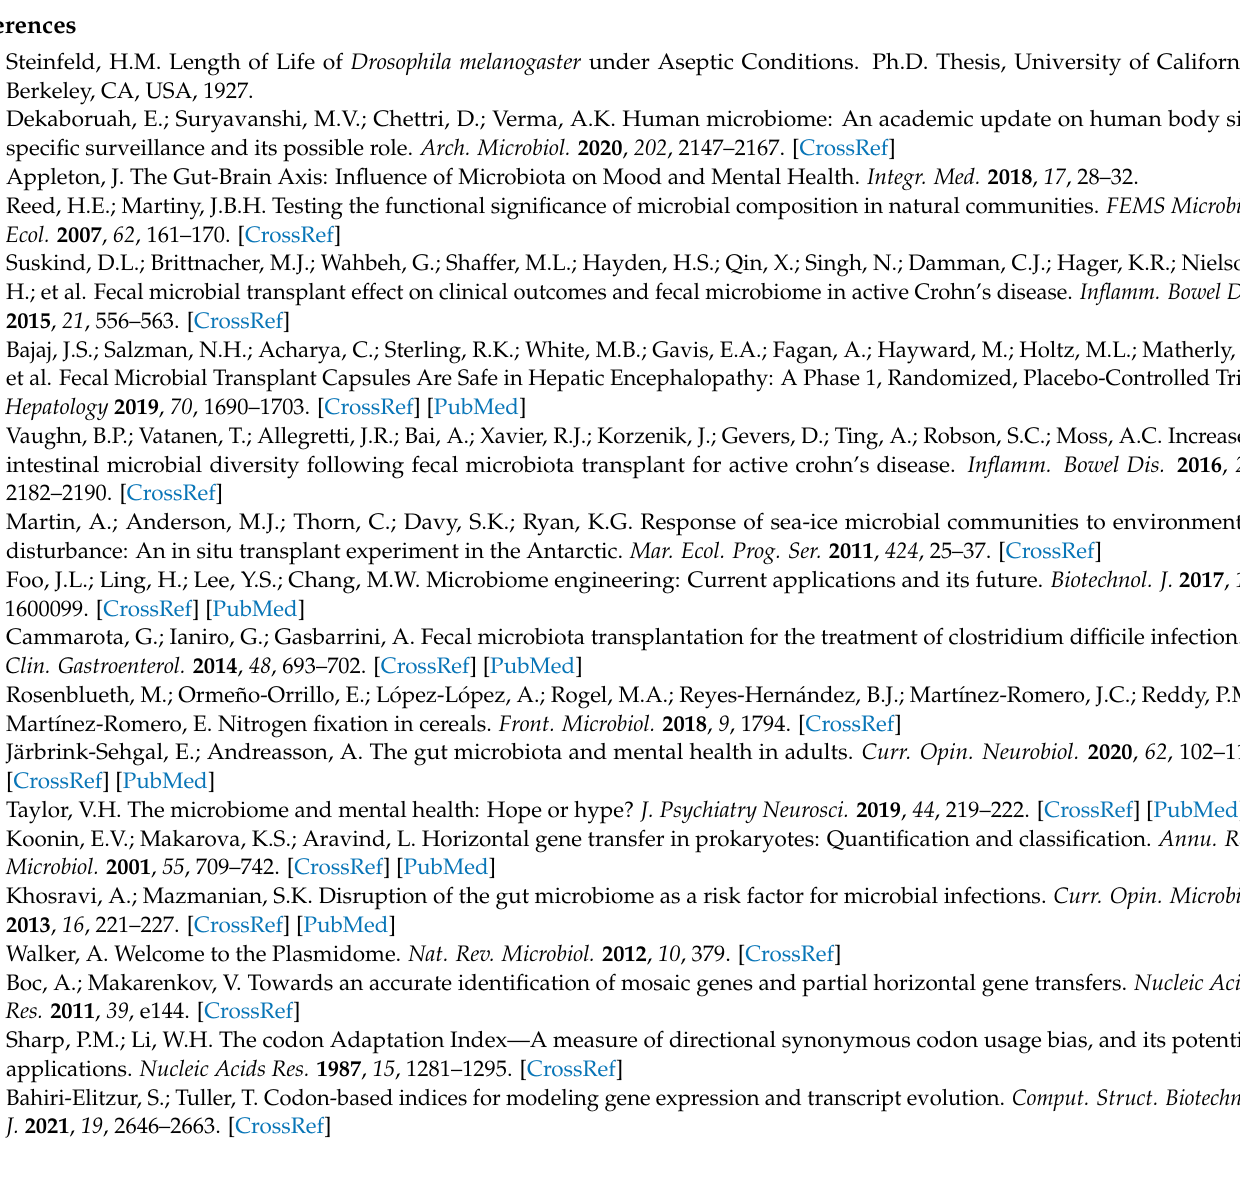
Figure A7. Integration of the algorithm in order to optimize the dairy production process. Genes that can improve the dairy production process (in terms of speed, quality, etc.) are inserted to the participating bacteria, thus optimizing the process.